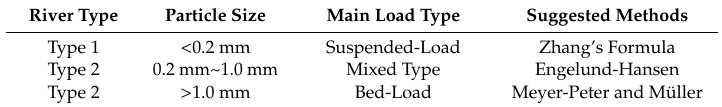
Table 1. River classification reference considering sediment parameter di ff